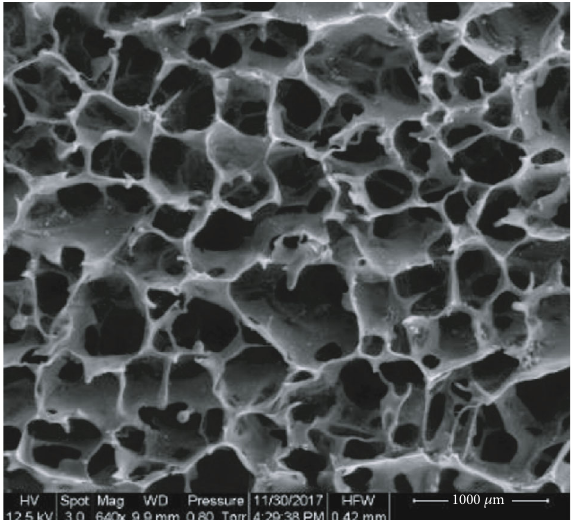
Figure 1: Microstructure of an SF sca ff old. Under SEM, a 3D porous structure with uniform pores of ~ 100 μ m in diameter can be observed (640x, scale bar = 100 μ